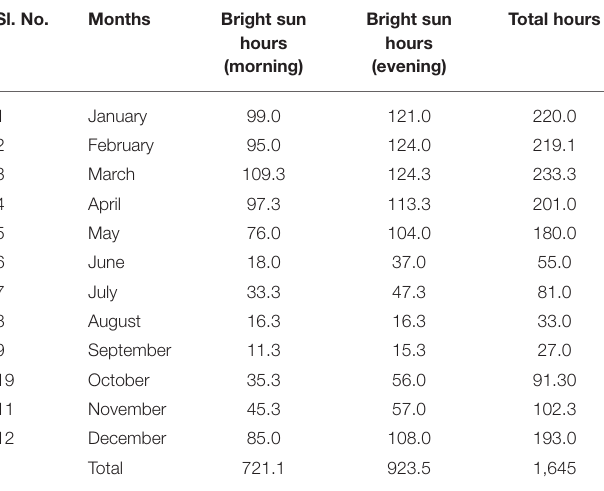
TABLE 3 | Average monthly bright sun hours at Pampadumpara station in CHR. Sl.